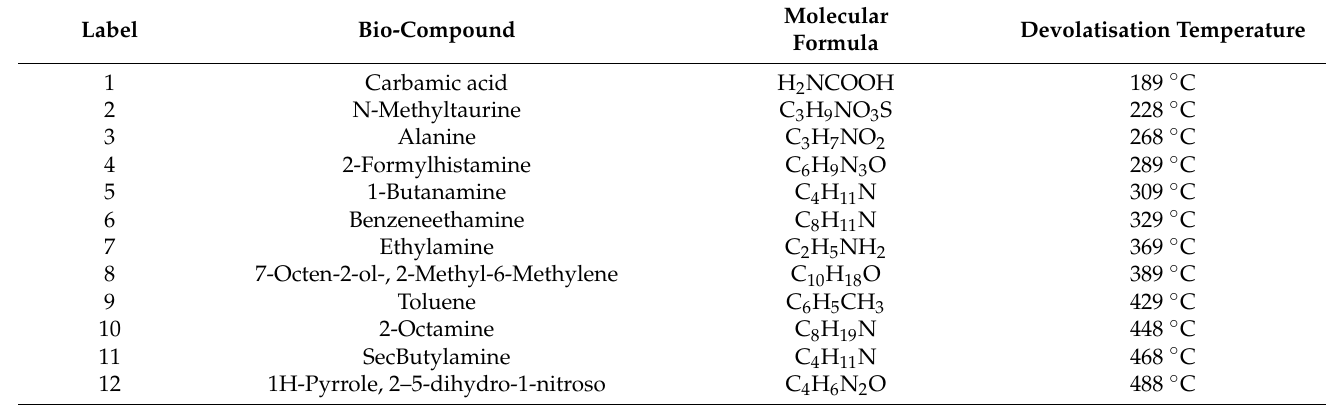
Table 4. Volatile compounds detected during the pyrolysis of the GC/MS analysis of photobioreactor microalgae consortium sample (A2).